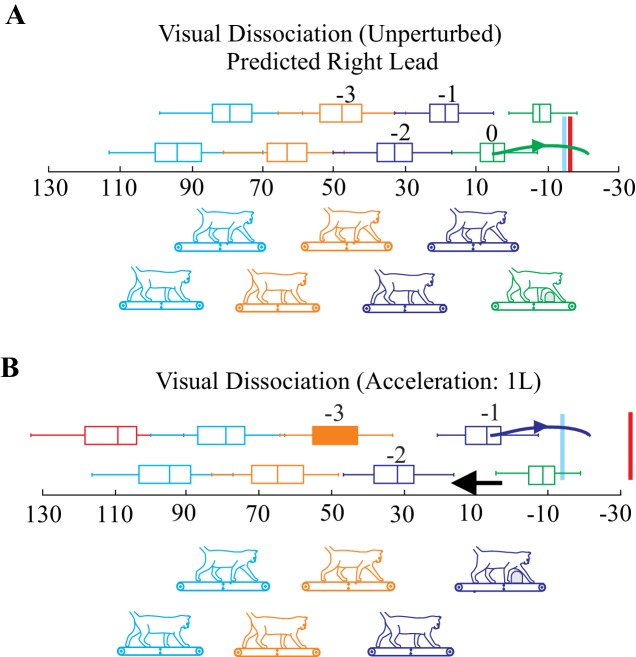
Effect of acceleration on gait pattern.The figure repeats the data from the top part of Figure 7A with the addition of cat figurines to better illustrate the change in the gait pattern produced by the acceleration in the 1L condition. (A) Unperturbed situation in the right limb lead condition. The gait before the step over the obstacle is regular and the cat steps smoothly over the obstacle with the right forelimb. (B) The acceleration during step −3 (filled orange box) quickly closes the gap between the cat and the obstacle. As a result, instead of placing the left forelimb in front of the obstacle, as in the top illustration (top dark blue cat figurine), the cat instead, lifts this left limb over the obstacle. Note that the distance of the cat from the obstacle is always measured with respect to the step over the obstacle.